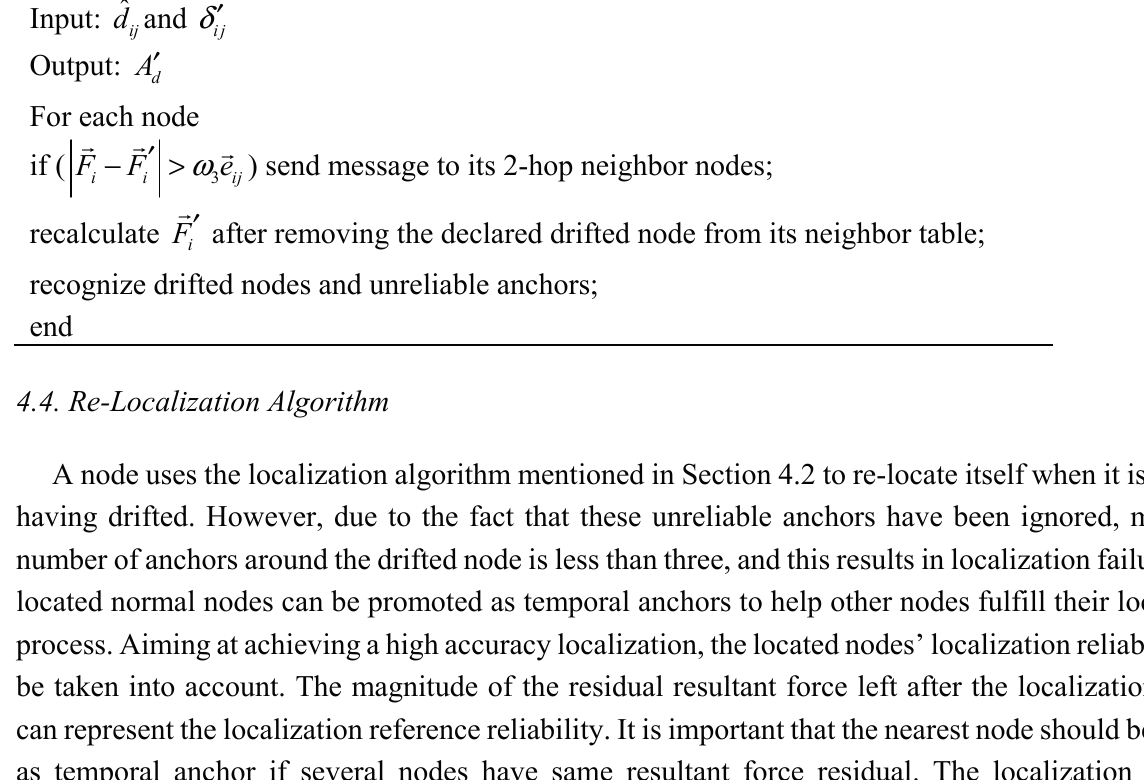
Algorithm 2 Location Verification